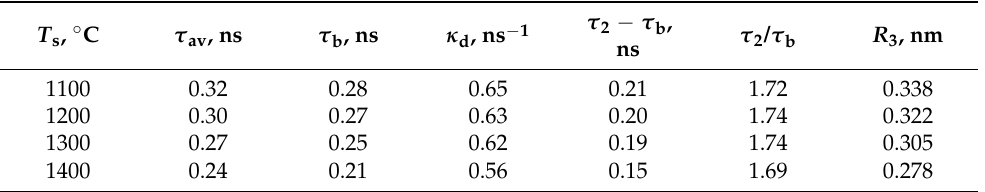
Table 1. Positron trapping parameters and nanopores radii for MgAl 2 O 4 ceramics sintered at Т s = 1100 – 1400 °C during 2 h. T s , °C